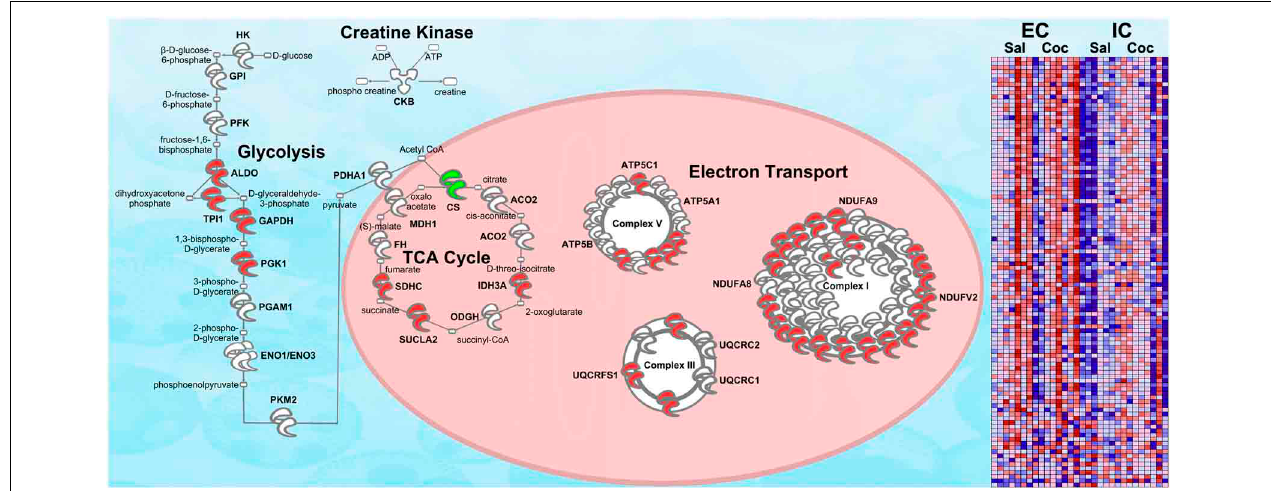
FIGURE 5 | RNA-sequpregulationofenergymetabolismgeneexpression. Transcripts whose expression was significantly increased in EC rats (main effect) are highlighted in red. Green denotes a decrease in expression. N = 7–8. This figure is an RNA validation of enrichment-induced upregulation